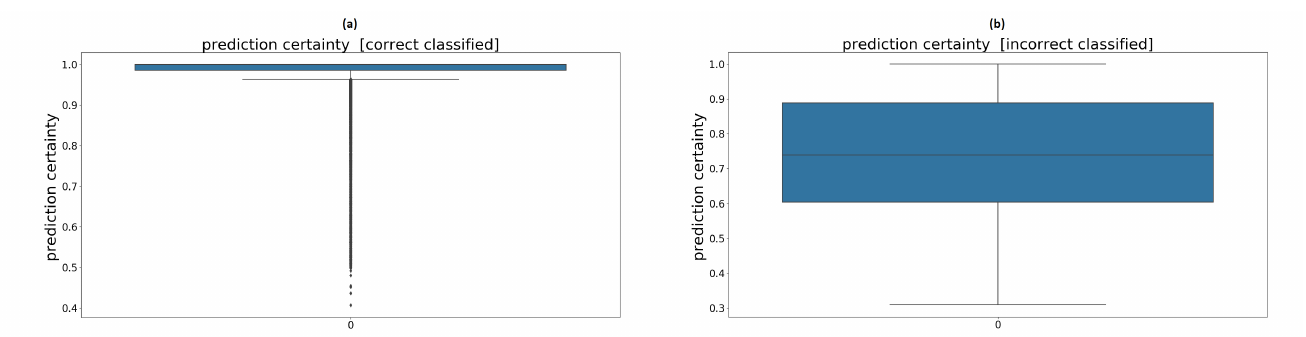
Figure 11. ( a ) Prediction certainty regarding correctly classified samples. ( b ) Prediction certainty regarding misclassi- fied samples.